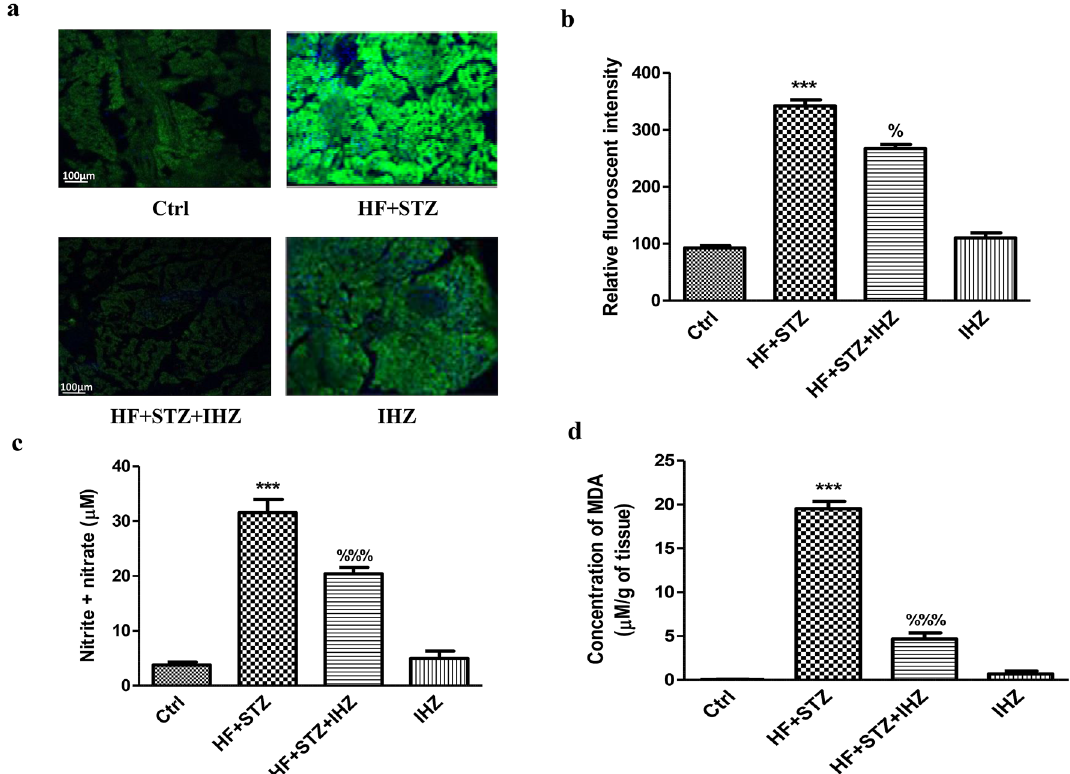
Figure 4. IHZ attenuates islet damage & fibrosis in pancreatic tissue of diabetic rats by inhibition of oxidative stress. ( a ) Representative images of histological pancreatic sections incubated with DCFDA to assess oxidative stress (high green fluorescence represents increased ROS generation). ( b ) Relative fluorescence intensity plotted from ( a ). ( c ) Nitrite or nitrate levels measured by Griess assay. ( d ) Lipid peroxidation levels measured by TBARS assay. Data is presented as mean ± SD of n = 3 animals for each group. ***P < 0.001 vs control group; %P < 0.05, %%%P < 0.001 vs HF + STZ